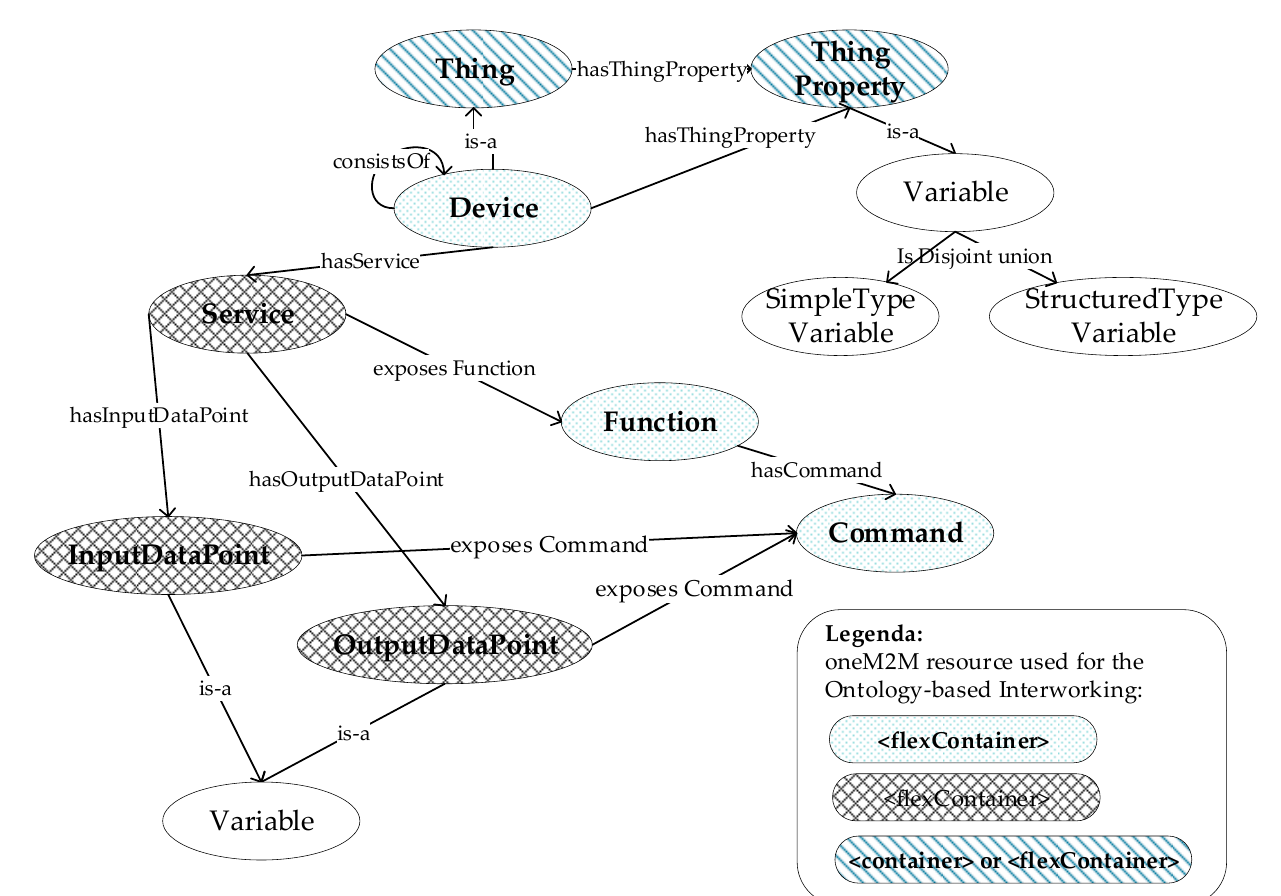
Figure 7. Classes and Properties of oneM2M Base Ontology.